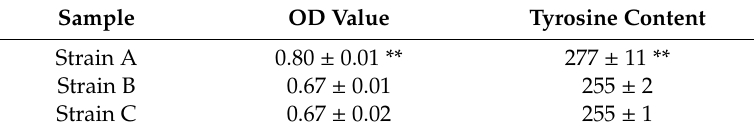
Table 2. The intensity of blue fluorescence of SF hydrogels excited by UV irradiation, in terms of OD values, for di ff erent strains of SF at 1.62 mM H 2 O 2 [29]. ( n =